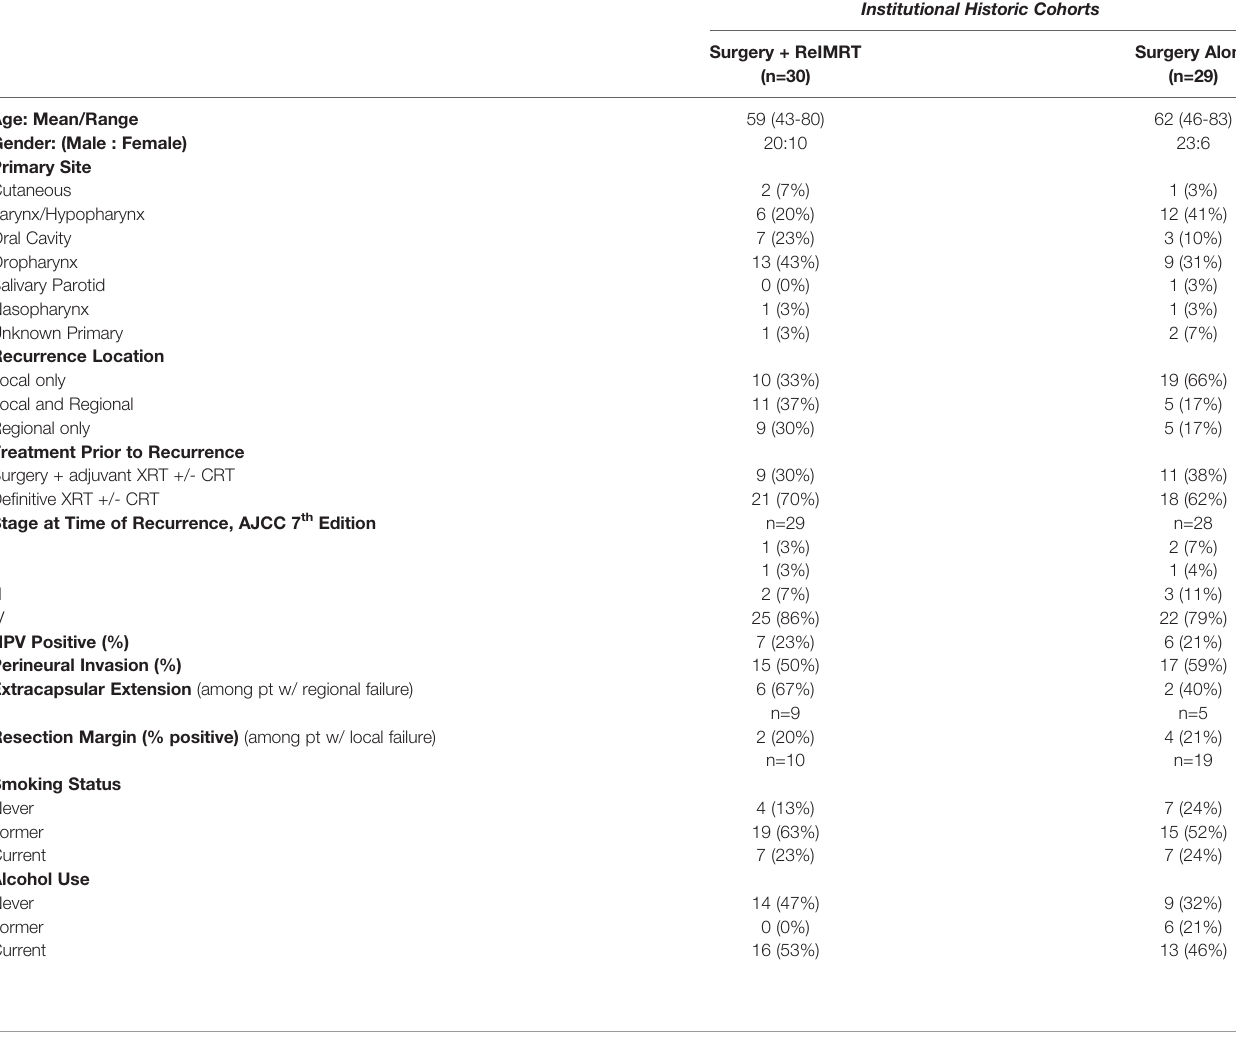
TABLE 2 | Demographic and tumor characteristics of the institutional historic cohorts.